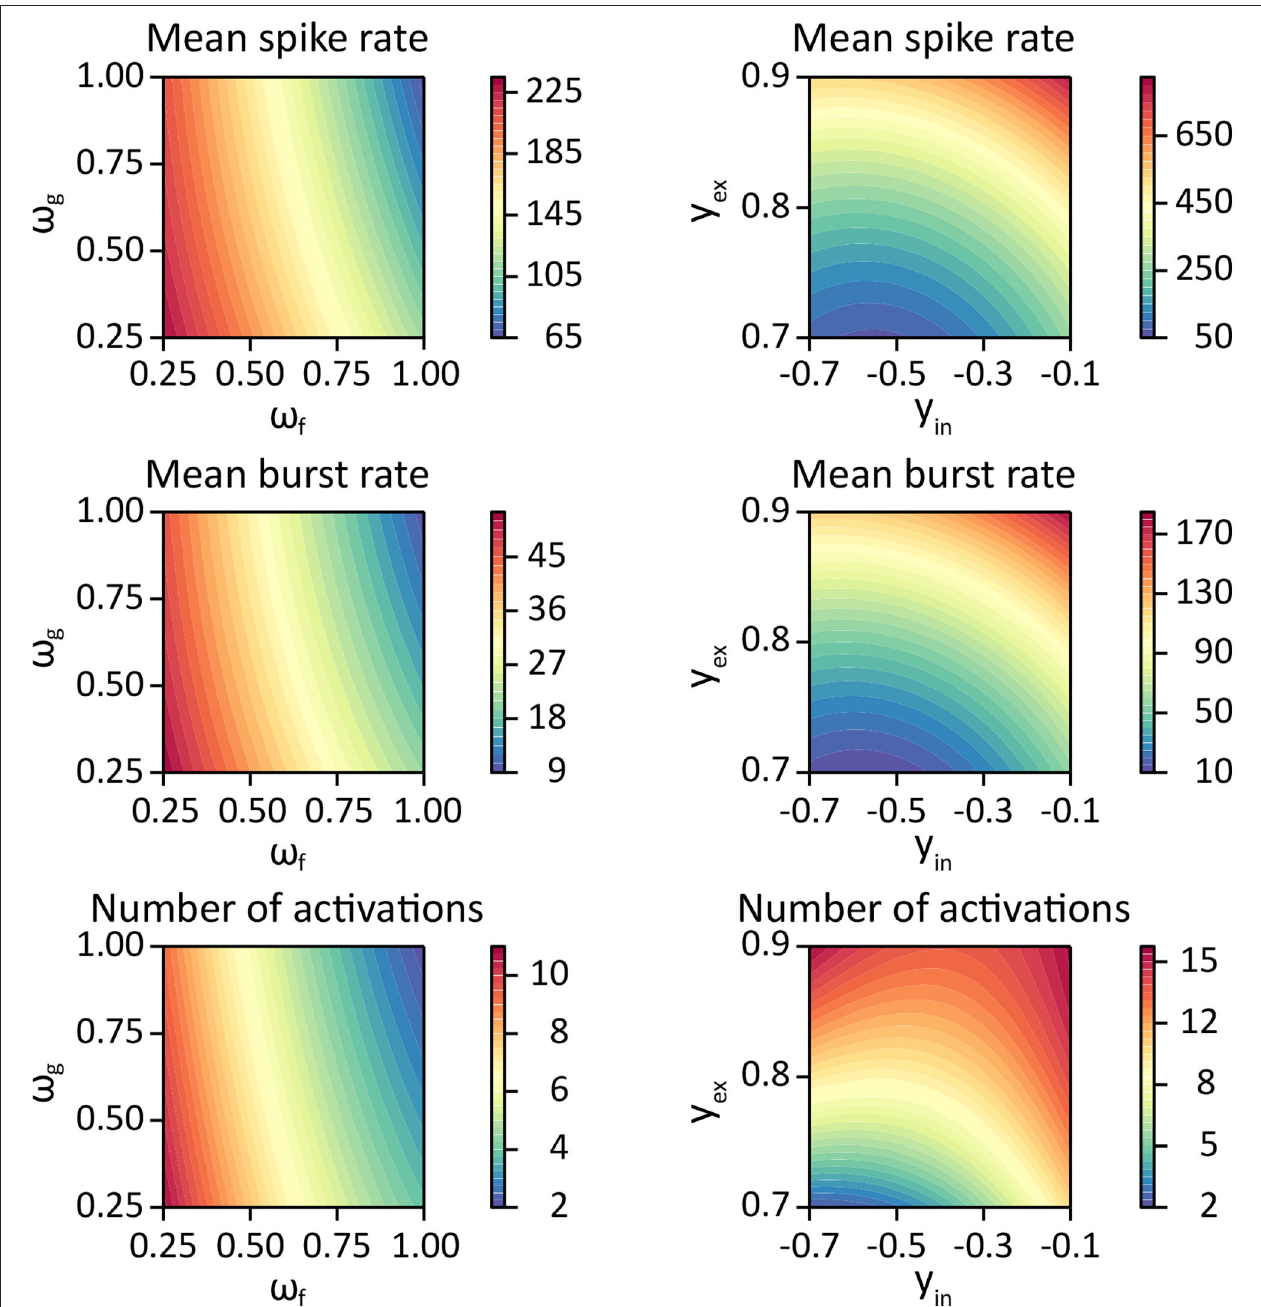
FIGURE 5 | Contour plots for each response variable as a function of glutamate dynamics parameters ω f , ω g (left column) using parameter estimates listed in Table 5 , and as a function of the synaptic weight bound parameters y in , y ex (right column) using the parameter estimates from Table 6